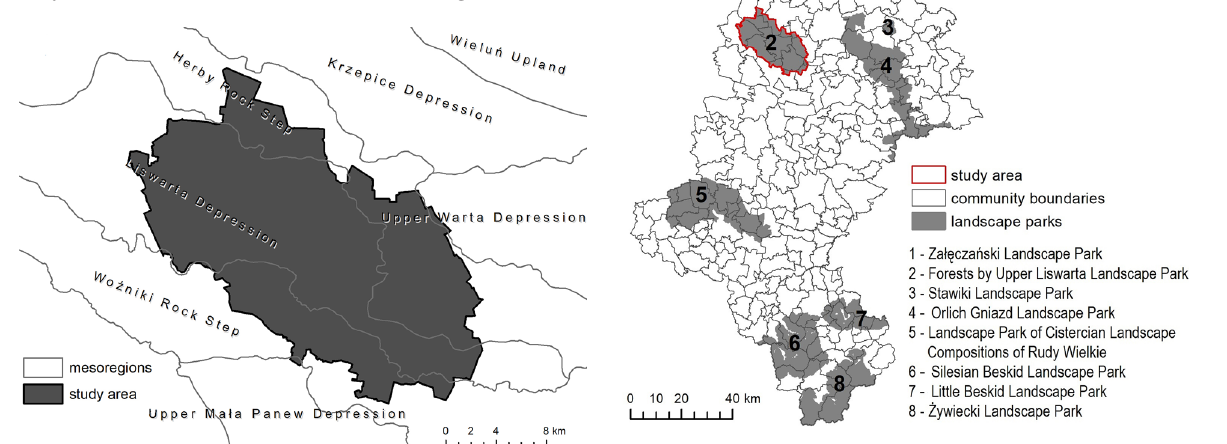
Fig. 3. Location of the Forests by Upper Liswarta landscape Park in the background of the communes of the Silesian